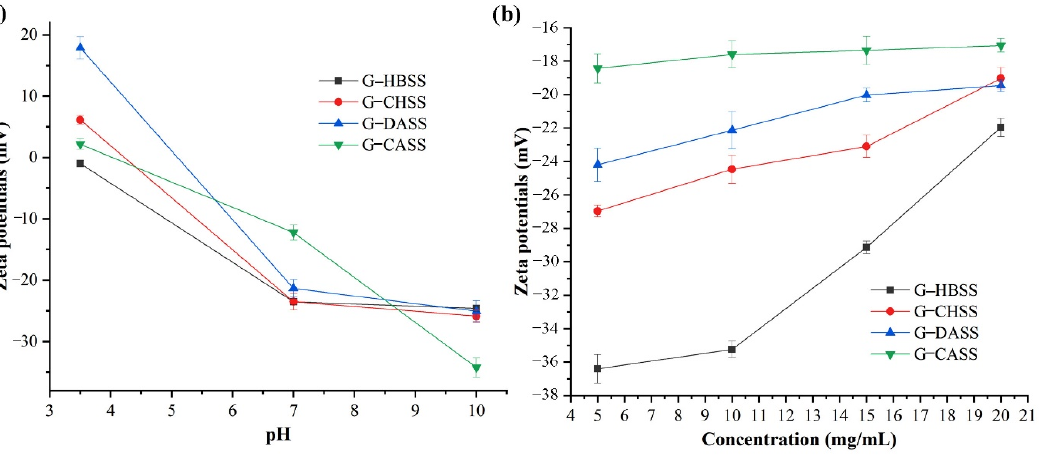
Figure 1. Zeta potential of G ‐ MLPs at 20 mg/mL as a function of pH ( a ); zeta potential of G ‐ MLPs as a function of concentration at pH 7 ( b ).